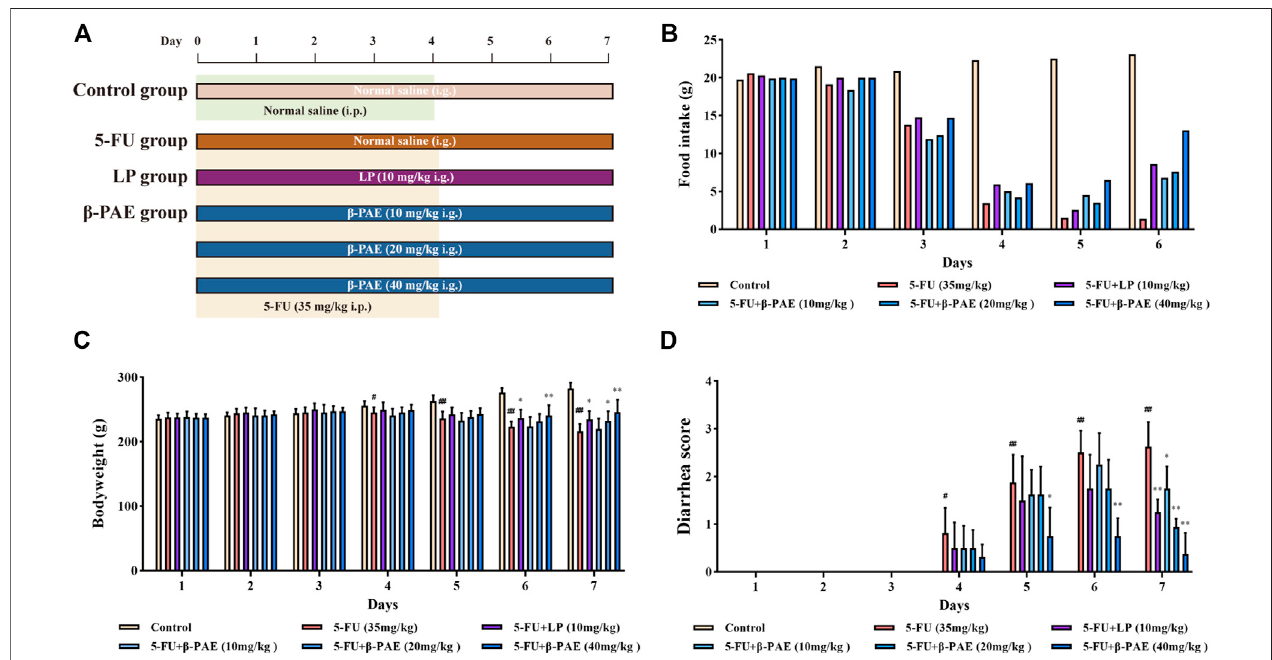
FIGURE 3 | Effects of β -PAE on the body characteristics. (A) Study scheme of β -PAE treatment in IM rats; (B) Food intake; (C) Bodyweight; (D) Diarrhea scores. Data are shown as mean ± SD ( n (cid:2) 8). # p < 0.05, ## p < 0.01 versus control group; * p < 0.05, ** p < 0.01 versus 5-FU group.